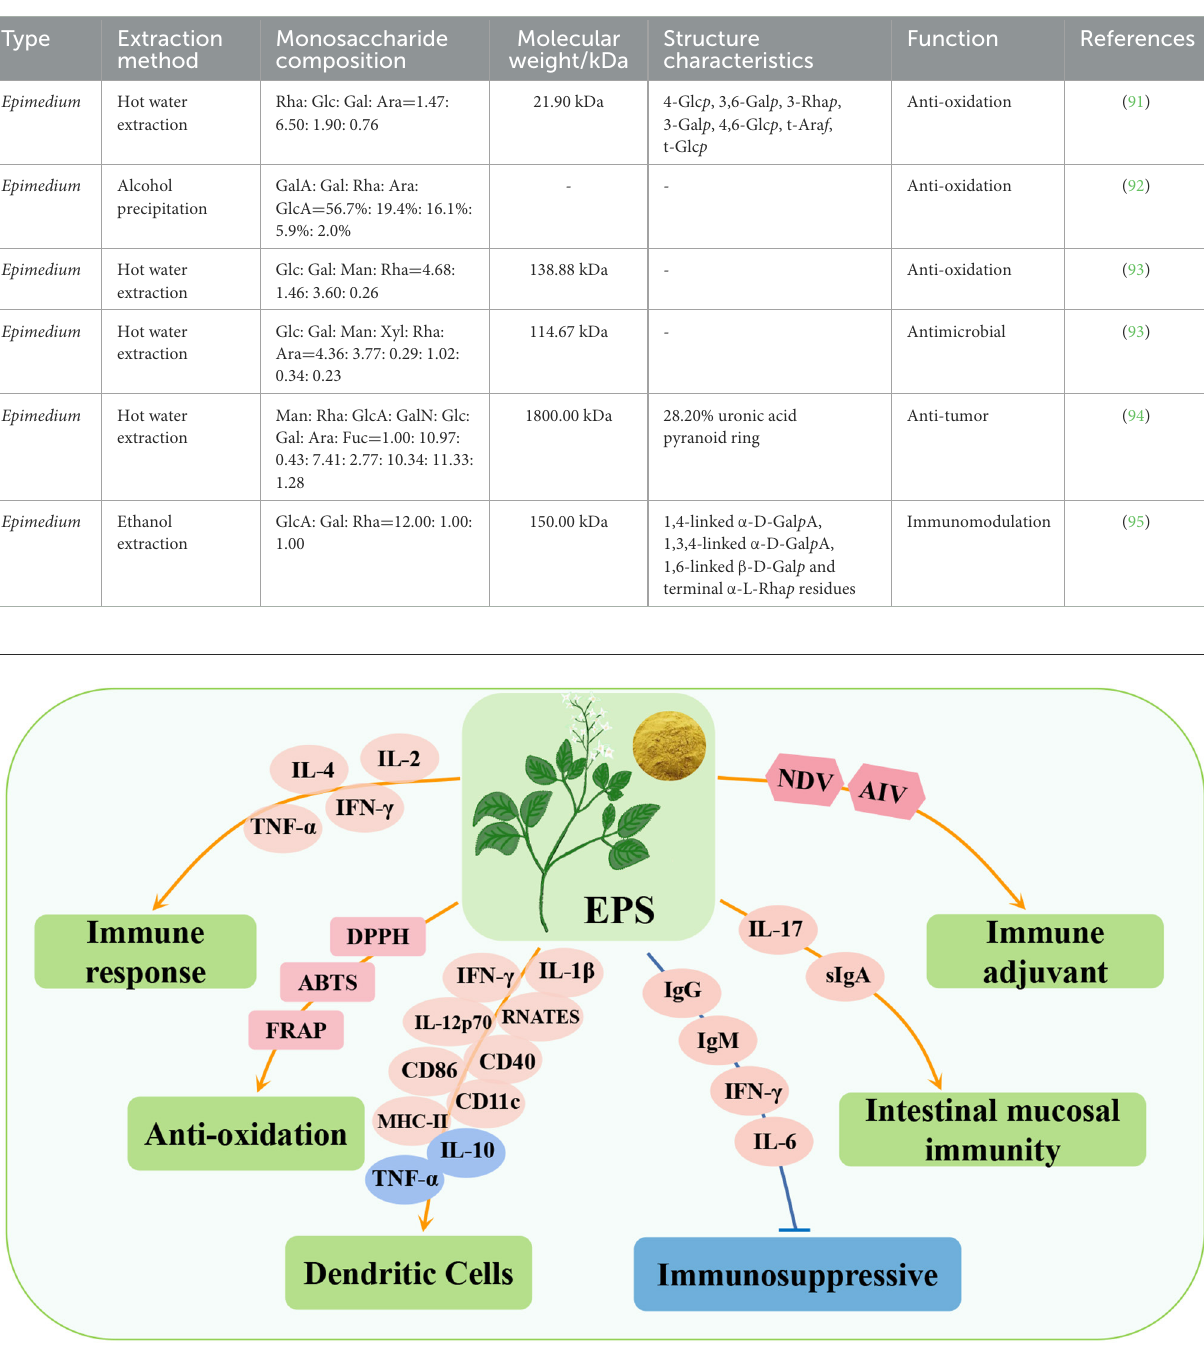
TABLE 5 Structure and structure-activity-relationship of polysaccharide from Epimedium .